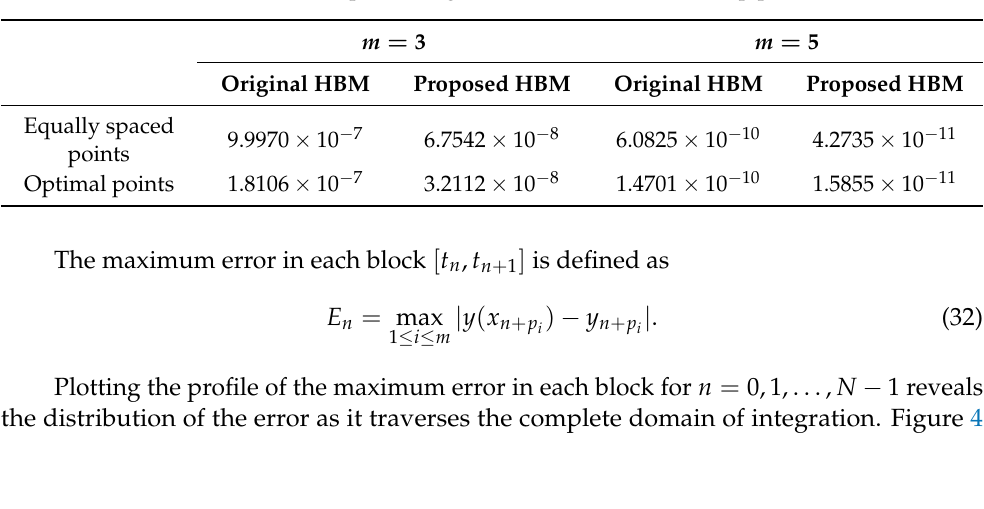
Table 3. Maximum errors for Example 1 using different choices of intra-step